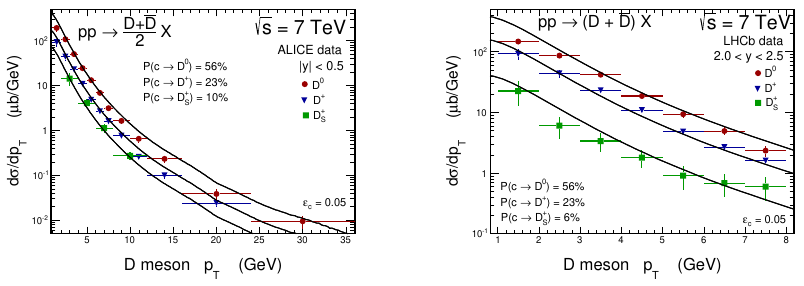
√ s = 7 TeV for ALICE (left panel) and